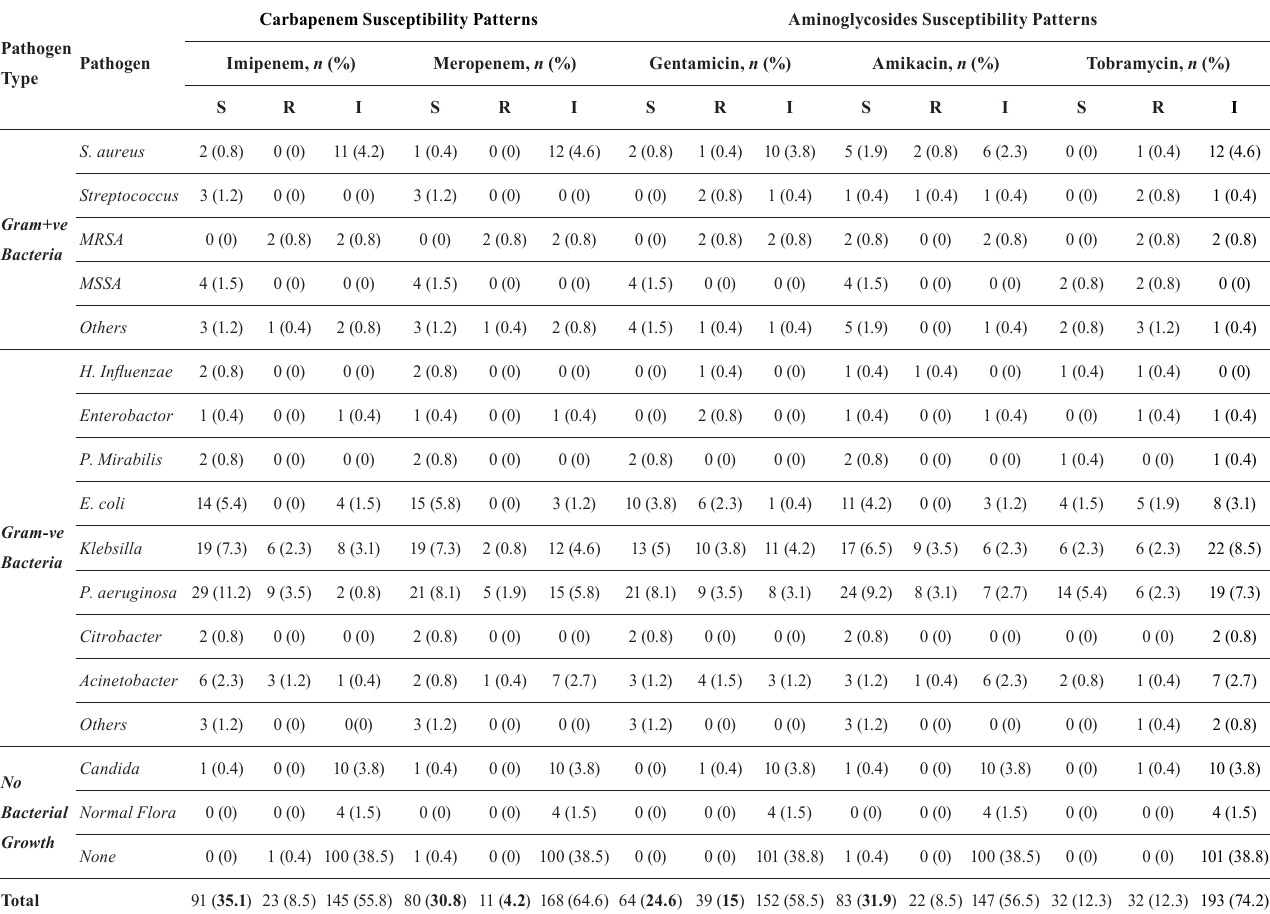
TABLE IV - Carbapenem and Aminoglycosides Susceptibility Patterns against Respiratory Tract Pathogens